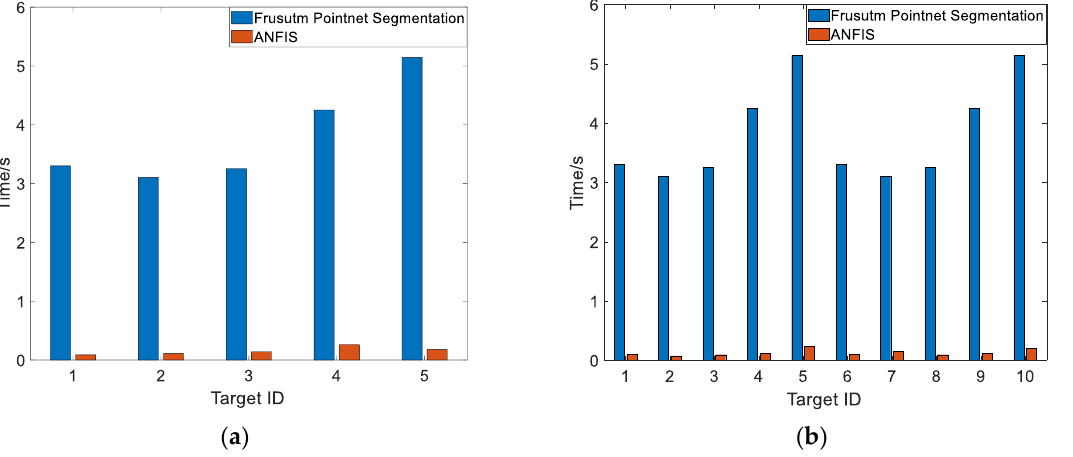
Figure 33. The comparison on time costs of different targets: ( a ) Time cost in the outdoor scene in Figure 25; ( b ) Time cost in the indoor scene in Figure 29.